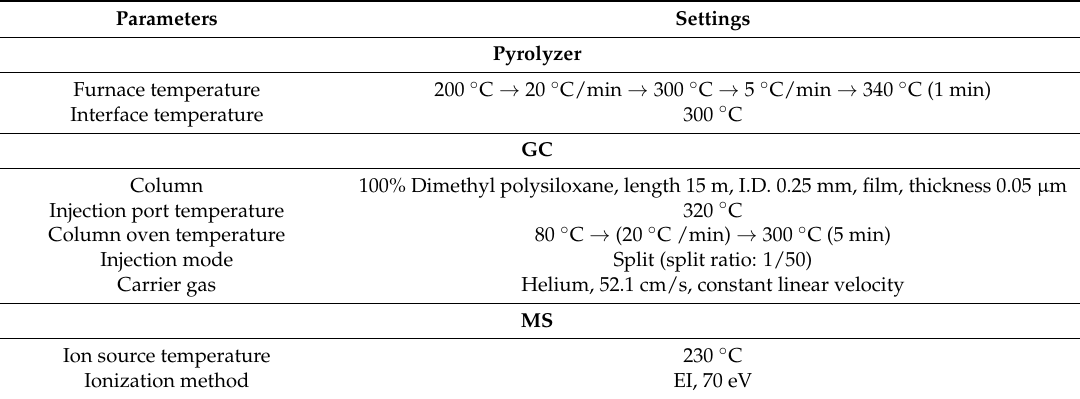
Table 3. Typical Py/TD heating conditions and GC–MS parameter settings.